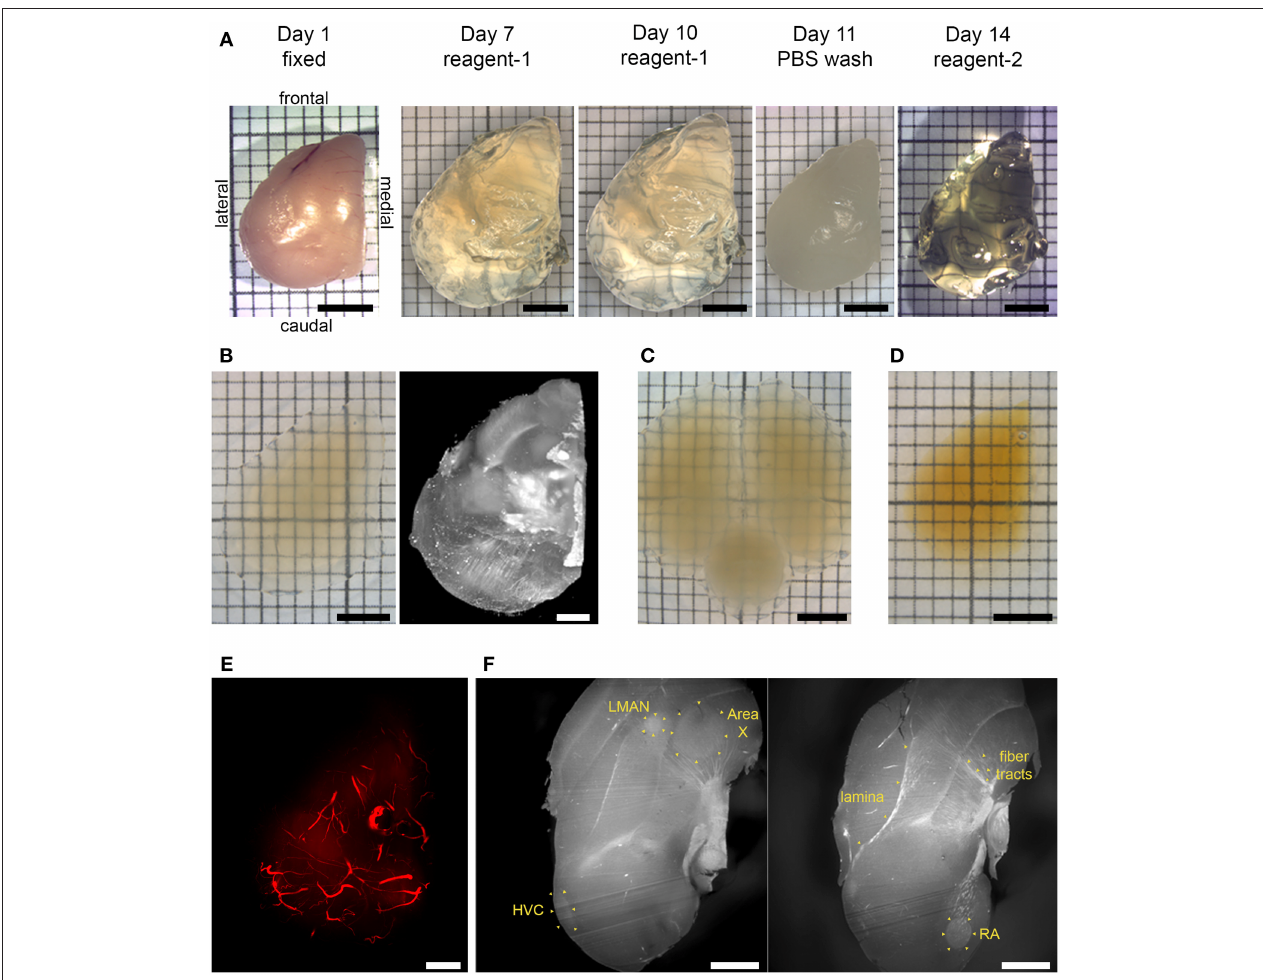
FIGURE 1 | Chemical clearing of songbird brain tissue and visualization of autofluorescent features. (A) CUBIC pipeline. A fixed hemisphere was treated with reagent-1 to remove lipid components initially for 7 days, with reagent-1 immersion prolonged to a total of 10 days to increase transparency. Lipid removal was followed by a PBS wash, and then by reagent-2 immersion for refractive index (RI) adjustment for 3 days. (B) CUBIC-cleared hemisphere in imaging solution (left), and volume rendering resulting from light sheet imaging of the same hemisphere (right; mesoSPIM, 1.6x zoom, no emission filter). (C) CUBIC-cleared whole brain in imaging solution. (D) iDISCO + cleared hemisphere in ethyl cinnamate. (E) Volume rendering of autofluorescent vasculature (mesoSPIM, 1.6x zoom). (F) Two sagittal optical sections showing autofluorescent anatomical landmarks, including laminae, myelinated fiber tracts, and song control nuclei HVC, RA, Area X, and LMAN (Ultra Microscope II, 1x zoom, 10 µ m light sheet thickness; top is frontal, bottom is caudal). Scale bars in (A,B) left inset, (C,D) are 3mm; in (B) right inset, (E,F) are 1mm. (A–E) Dorsal